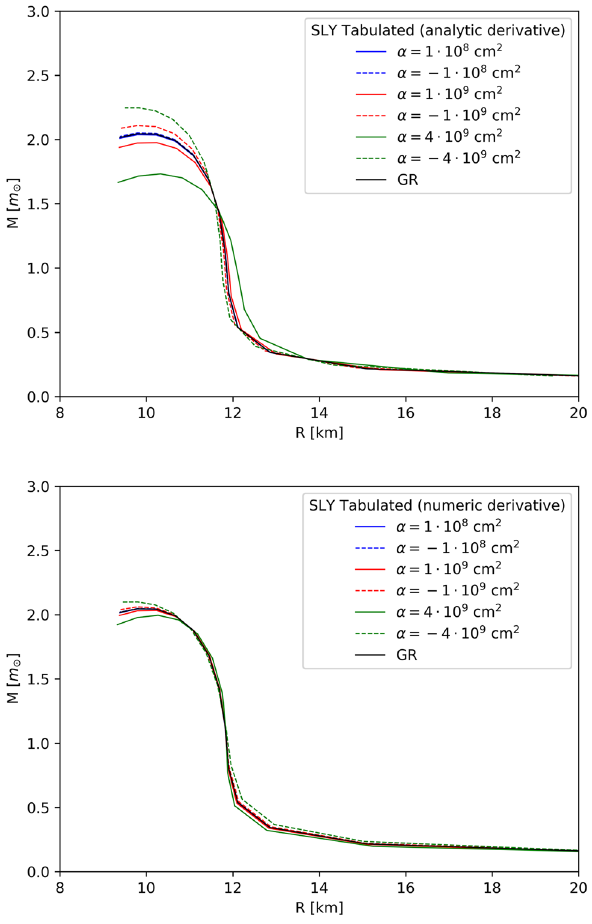
Fig. 11 Mass-radius relation for fake tabulated SLy EoS using the exact values for the derivative (left panel) and the values derived by the finite difference method (right panel)